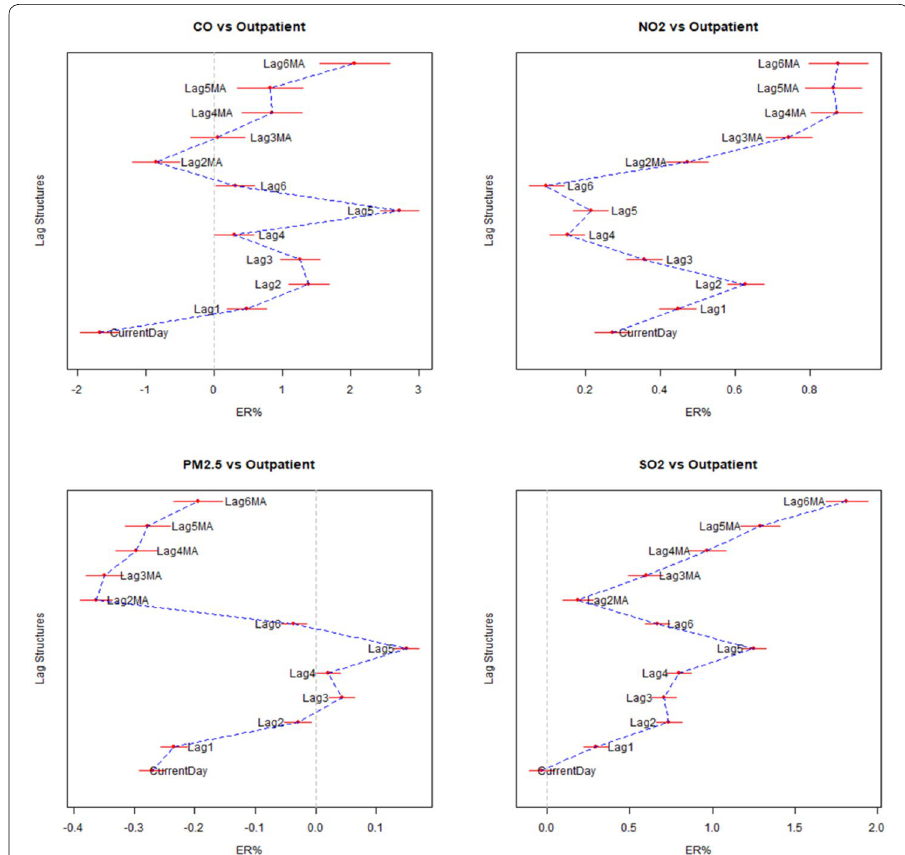
Fig. 3 Percent increase (excess risk, ER) with different lag structures for total outpatient admissions (three hospitals) due to fossil fuel‑related air pollutants. ER for every unit (10 μg/m 3 ) increase in NO 2 , PM2.5, and SO 2 concentrations and for every 1 mg/m 3 increase in CO concentration. ER values obtained by single‑pollutant regression. The X‑axis represents ER values and the Y‑axis is the different lag structures. Red bars indicate 95% confidence intervals of ER. Lag1 to Lag6 are simple lag effects and Lag2MA to Lag6MA are 2‑day to